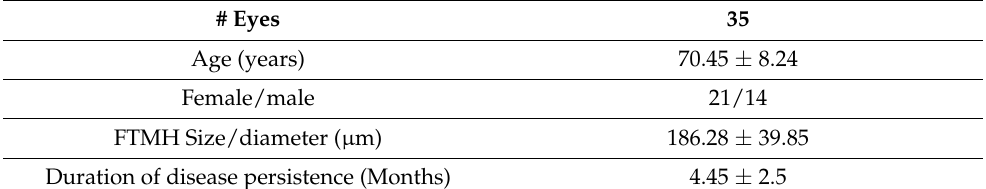
Figure 2. Spectral-domain structural optical coherence tomography (SD-OCT) horizontal B-scan and OCT-A before and 1-year after surgery for FTMH in eye with worsening of visual acuity. In OCT-A, the superficial and deep vascular plexuses show the vascular defect in juxta-foveal temporal region in correspondence with inner layers defect. The SD-OCT B-scan shows the ellipsoid zone defect in foveal area and the inner layer profile changes for layer defect probably after inner limiting membrane removal. Table 1. Demographic and clinical data before surgery procedure (mean ± standard deviation).